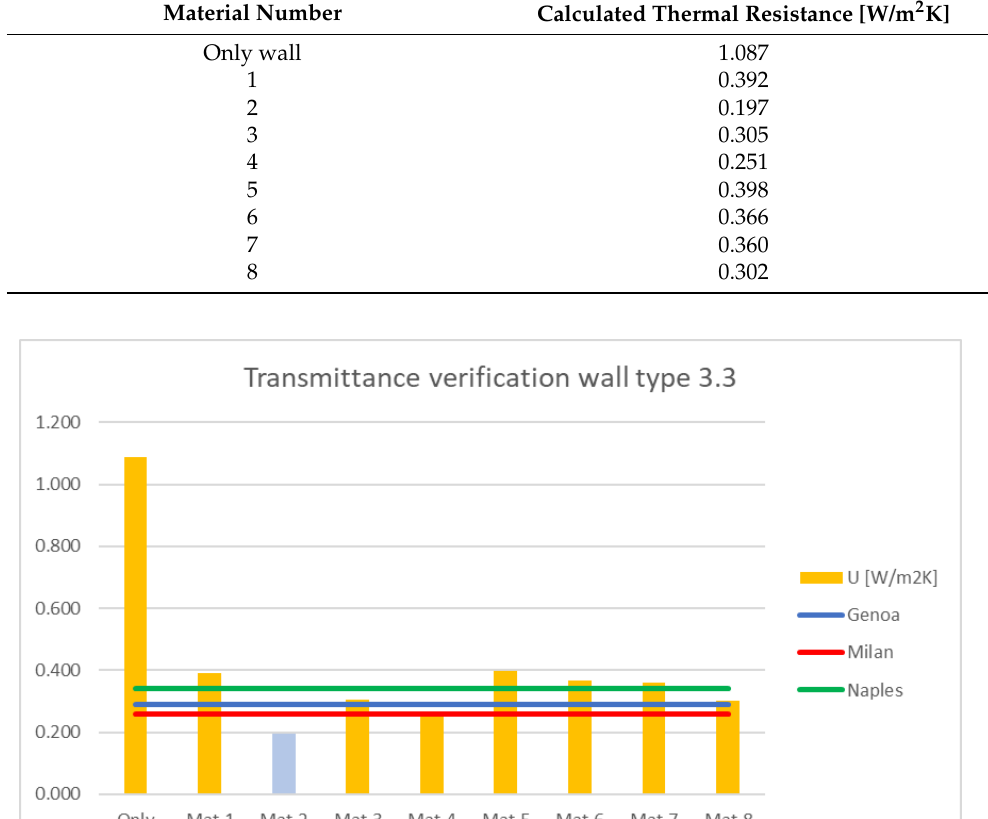
Figure A11. Wall type 4: stratigraphy with thicknesses and conductivities for the different layers. The numbers start from the outside.